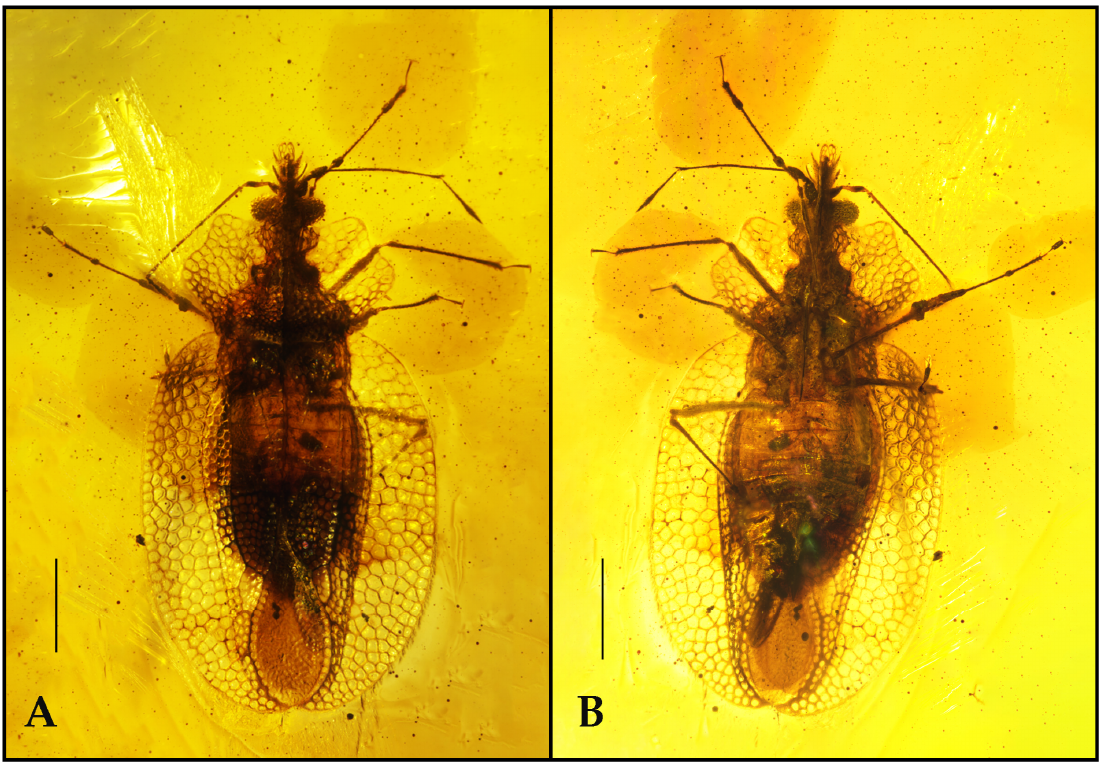
Figure 1. Habitus of Latidorsum carinbifarium gen. et sp. nov., holotype CNU-HET-MA2014010. ( A ) Photograph in dorsal view. ( B ) Photograph in ventral view. Scale bars = 0.5 mm.